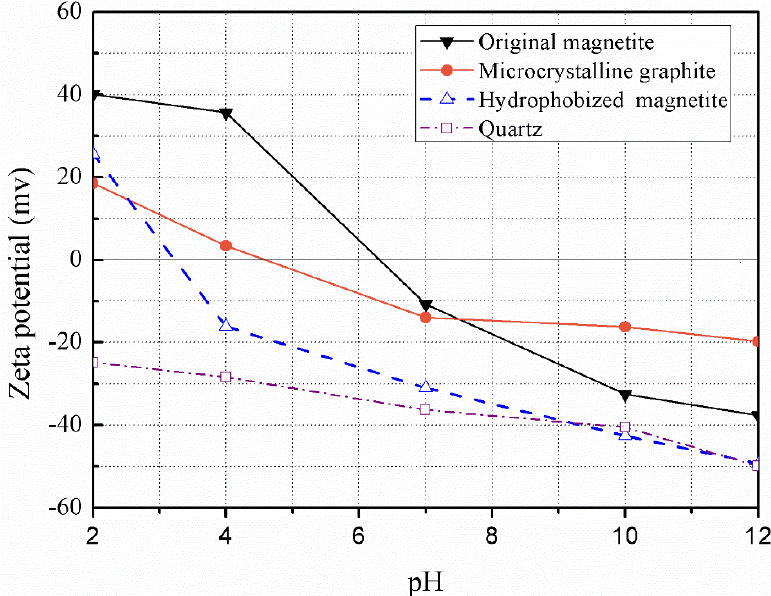
Figure 7. Zeta potentials of microcrystalline graphite, quartz, magnetite, and hydrophobic magnetite as a function of pH in 1.0 × 10 − 4 M KCl solution.